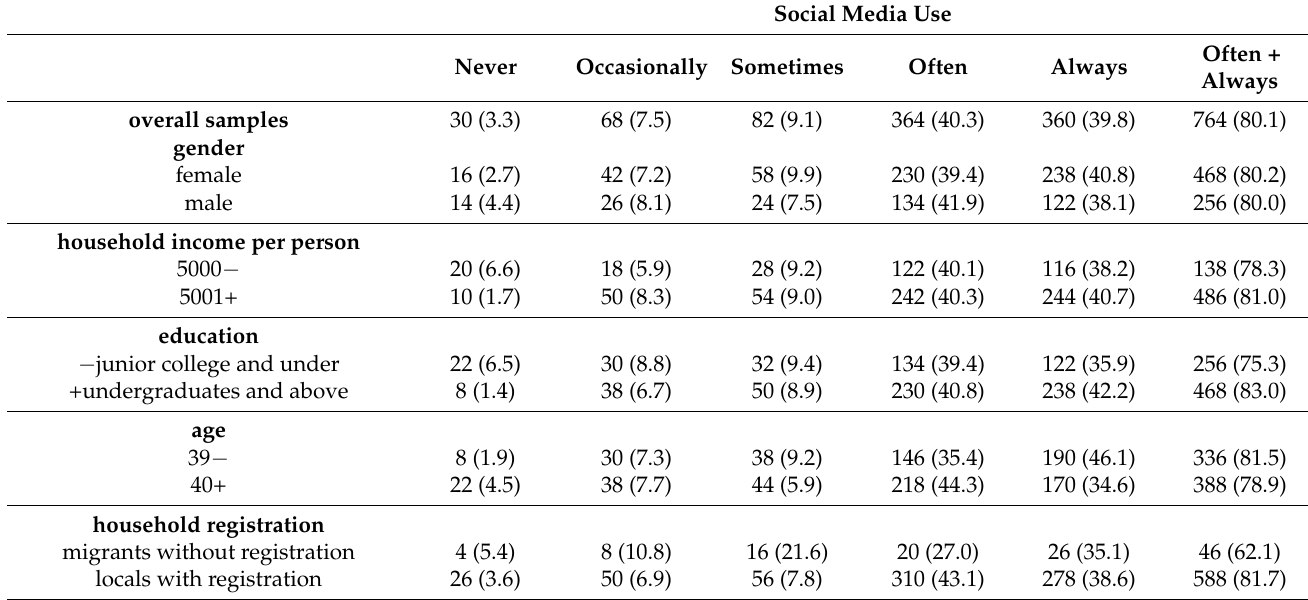
Table 3. The comparison of social media use among different groups.